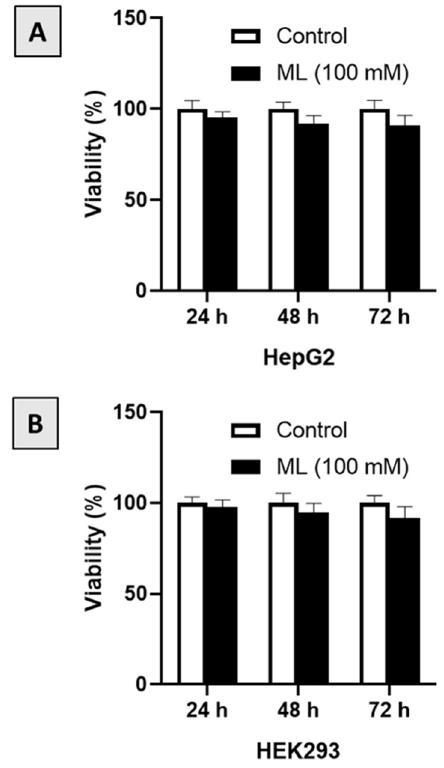
Figure 2. Cytotoxic effects of ML on HepG2 ( A ) and HEK293 ( B ) cells after exposure for 24, 48 and 72 h as determined by MTT assay. Data presented as mean ± SD.